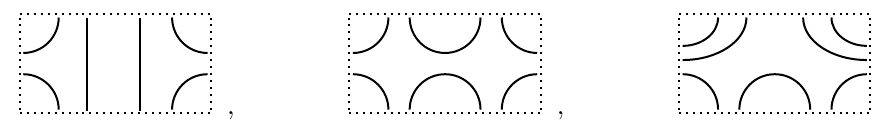
Figure 1 . Three examples of a(cid:14)ne diagrams for N = 4, with the left and right sides of the framing rectangle identi(cid:12)ed. The (cid:12)rst diagram represents e 4 , the second e 2 e 4 , and expressing the last one is left as an